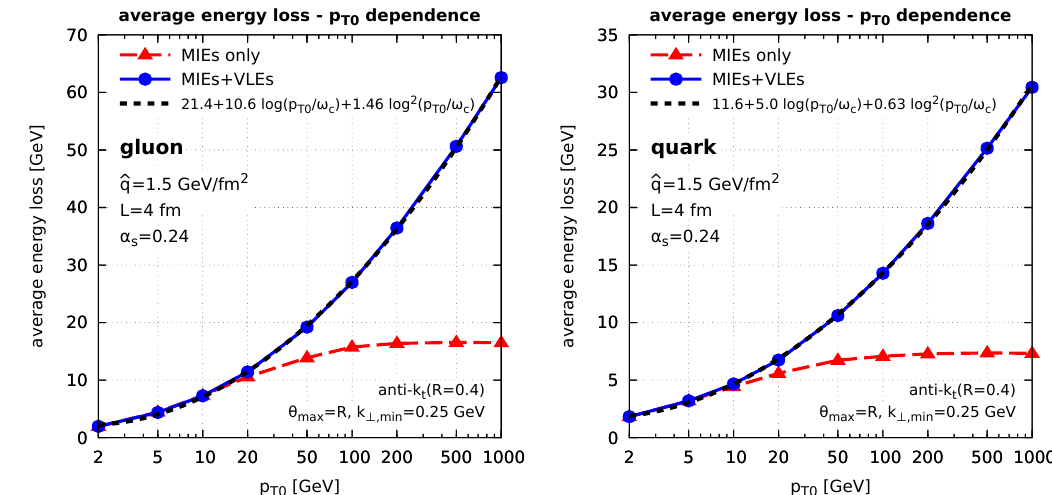
Figure 4 . The MC results for the average energy loss by a gluon-initiate jet (left), respectively, a quark-initiated one (right), is displayed as a function of the initial energy p T 0 of the leading parton, for two scenarios for the jet evolution: jets with MIEs only (triangles) and full showers with both MIEs and VLEs (circles). The dashed line shows the quadratic (cid:12)t to the energy loss by the full parton